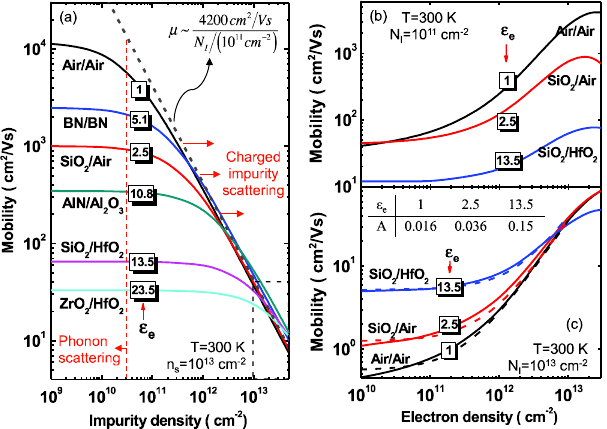
FIG. 7. The room-temperature net electron mobilities in SL MoS 2 , considering all kinds of scattering mechanisms as a function of (a) N with fixed n at 10 13 cm − 2 ; (b) and (c) n I s with N fixing at 10 11 and 10 13 cm − 2 , respectively. The numbers I on the curves show the average dielectric constant of the surrounding dielectrics. Dashed lines show the fitted electron